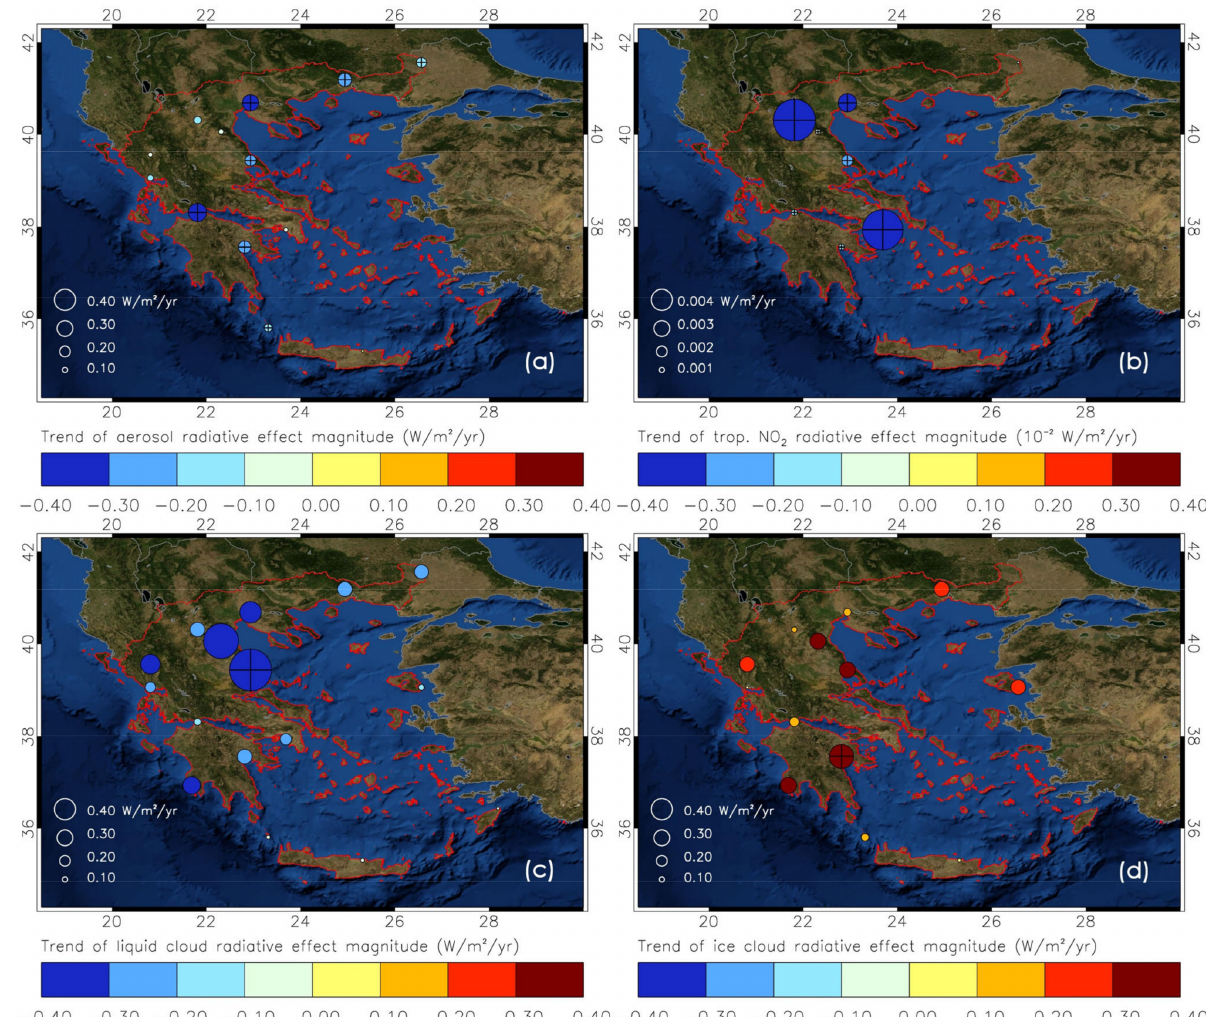
Figure 9. Trend of the radiative effect of ( a ) aerosols, ( b ) tropospheric NO 2 , ( c ) liquid clouds and ( d ) ice clouds for the period 2005–2019 over 16 locations in Greece. Statistically significant trends at the 95% confidence level are indicated with a